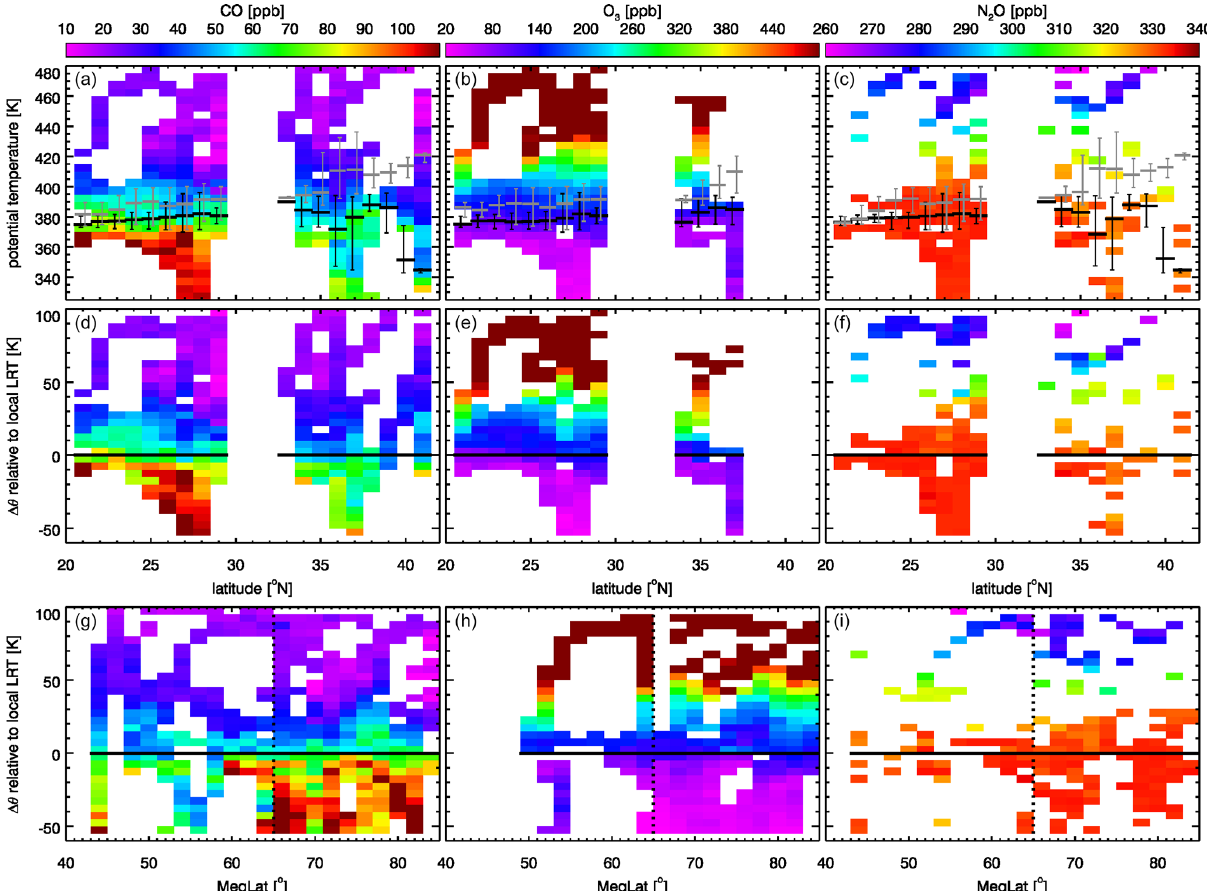
Figure 3. Panels (a–c) show CO (a) , O 3 (b) and N 2 O (c) mixing ratios averaged from both deployments into 1 ◦ latitude × 5K potential temperature bins. Black and grey bars show average and minimum/maximum LRT and CPT heights, respectively, for all measurements made in each 1 ◦ latitude bin. Note that the bins with valid data for CO, O 3 and N 2 O do not exactly match due to different data coverage for the AMICA, FOZAN and HAGAR instruments. Panels (d–f) show the same data with potential temperature relative to the LRT (see Sect. 2.3.1) as the vertical coordinate. In panels (g–i) , the horizontal coordinate is transformed to MeqLat with the vertical dotted line marking the 65 ◦ ASM anticyclone boundary (see Sect. 2.3.2). The number of samples and standard deviation in each bin are given in Fig. S5 in the